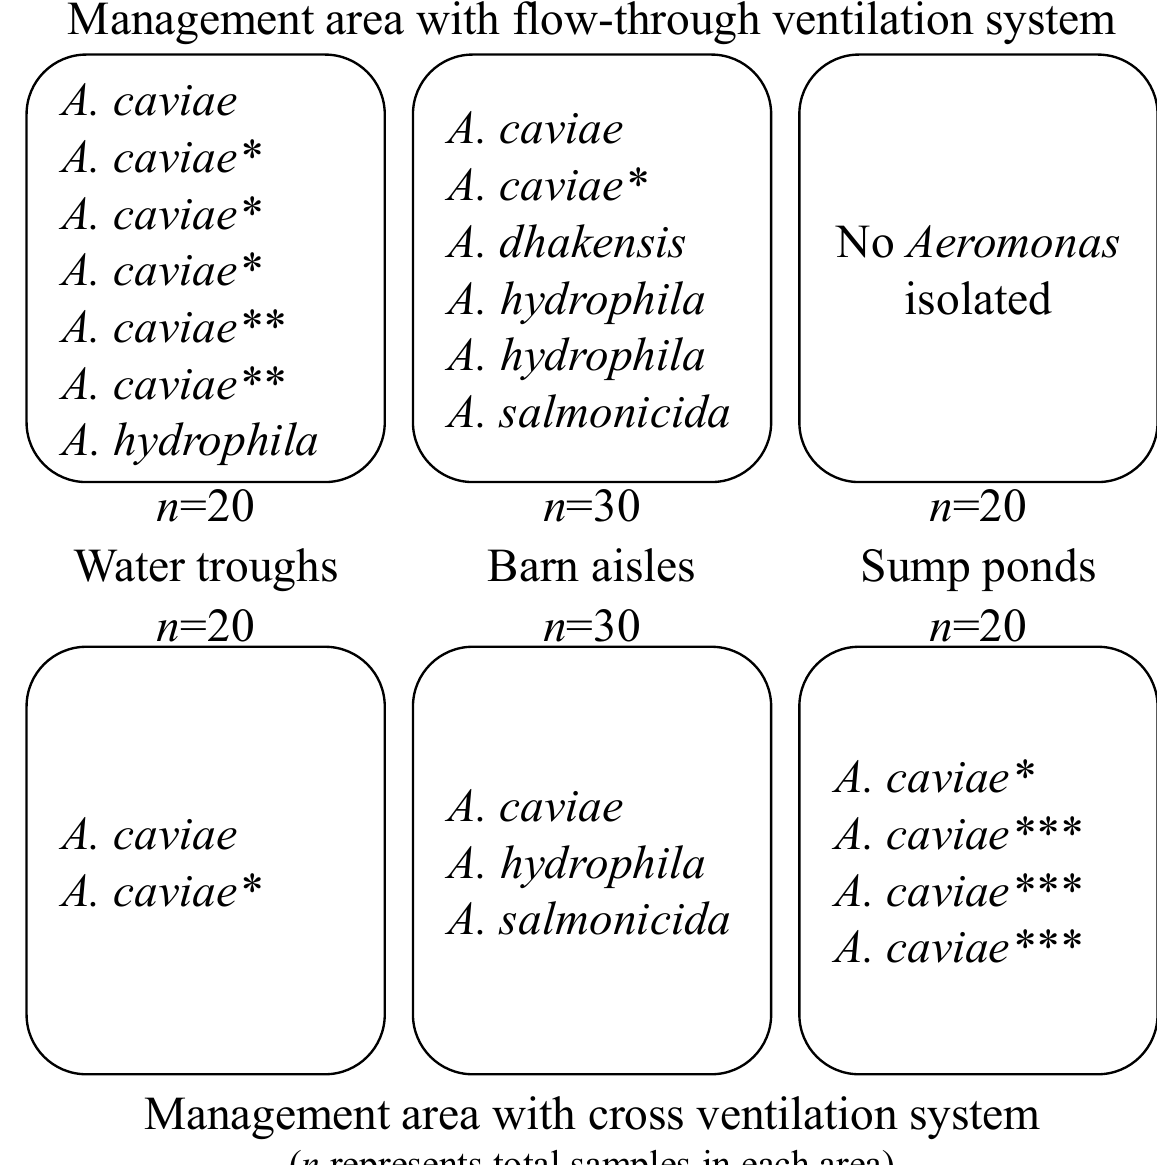
Figure 2. Location of Aeromonas positives on the farm.